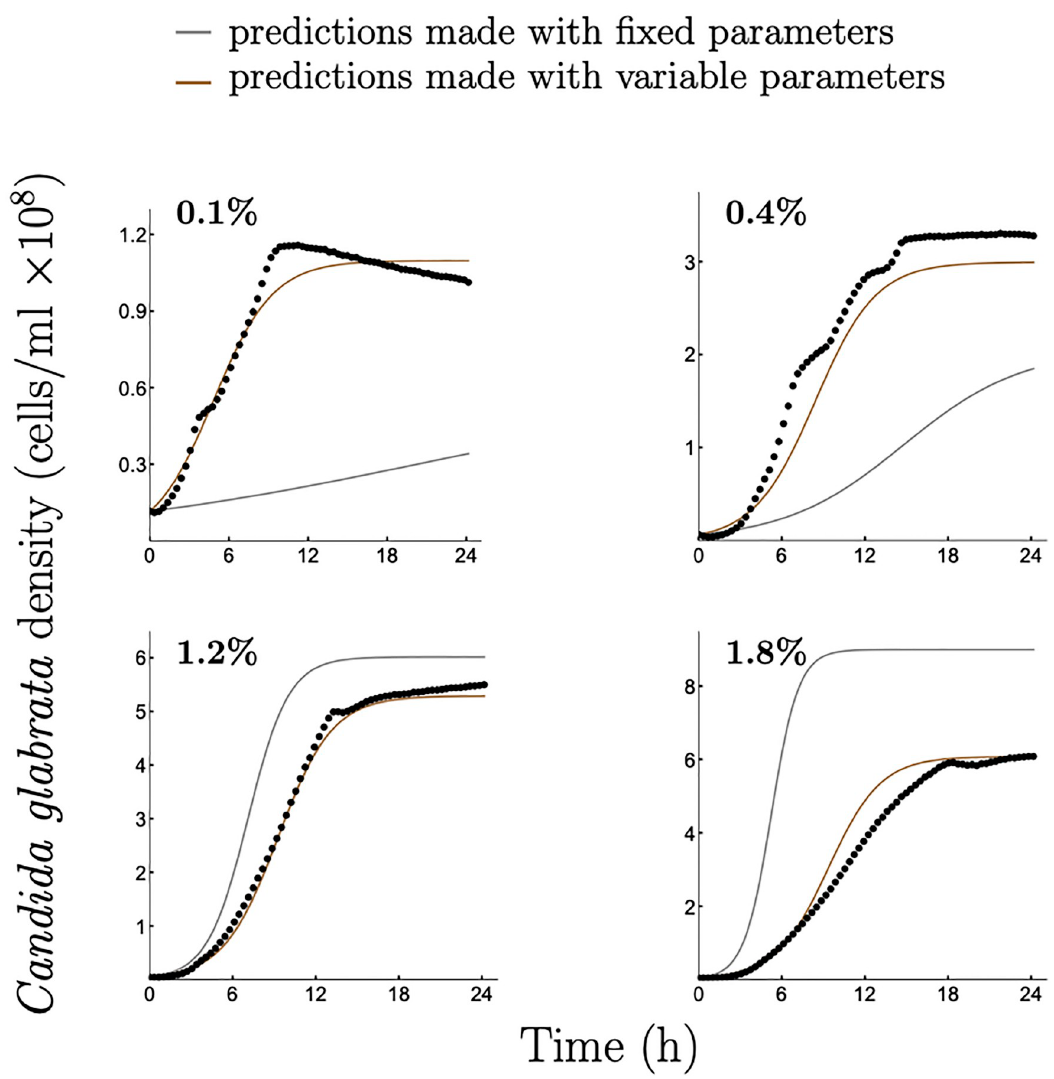
Fig 3. Comparison of growth predictions made by two modelling approaches, one using fixed and the other variable growth kinetic parameters. Experimentally obtained growth data for C. glabrata at different glucose concentrations (0.1%; 0.4%; 1.2%; 1.8%) are denoted by dots. Gray curves represent predictions of a model with fixed growth parameters estimated at the 1% initial glucose concentration (see S1 Text, Appendix B, B5 Fig (b) for growth data at 1% glucose). Brown curves represent predictions of a model with variable growth parameters as proposed in this study with [ a , b ] = [0.025%, 2%] in Step 1. To quantify the accuracy of the predictions made by the two approaches the Root Mean Square Error (RMSE) was calculated (see S1 Text, Appendix A, A8 Table for more details). Note, y-axis scale changes between